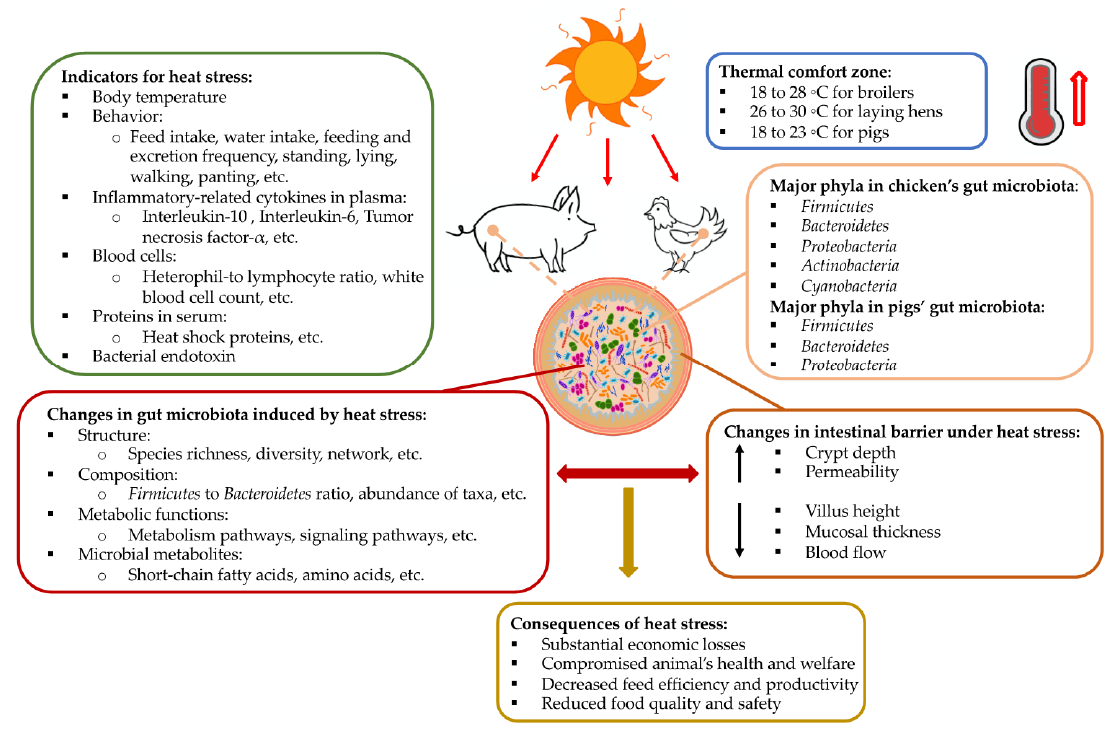
Figure 1. A schematic summary of the impact of high ambient temperatures on the gut microbiota and intestinal morphology in monogastric agricultural animals: pig and chicken. Other related information—including commonly used biomarkers of heat stress, thermoneutral zones for pigs and chickens, main components of the gut microbiota, and consequences of heat stress—are also in- cluded.